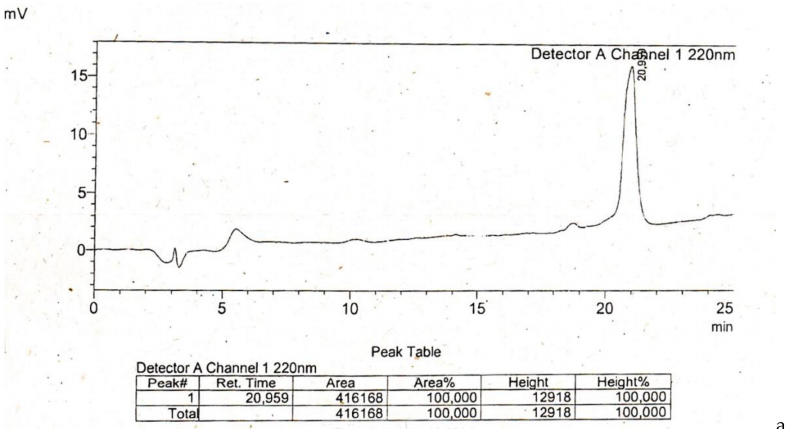
Figure A1. Analysis by high-performance liquid chromatography (HPLC) of Stigmurin